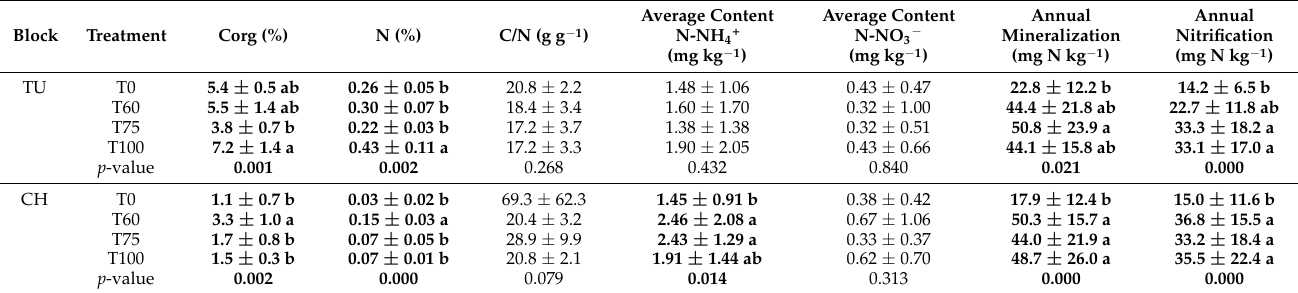
Table 1. Effects of silvicultural treatments on total organic C and N, net cumulative mineralization and nitrification for each block (one-way ANOVA), and effects of silvicultural treatments on ammonia and nitrate for each block (repeated measured ANOVA).